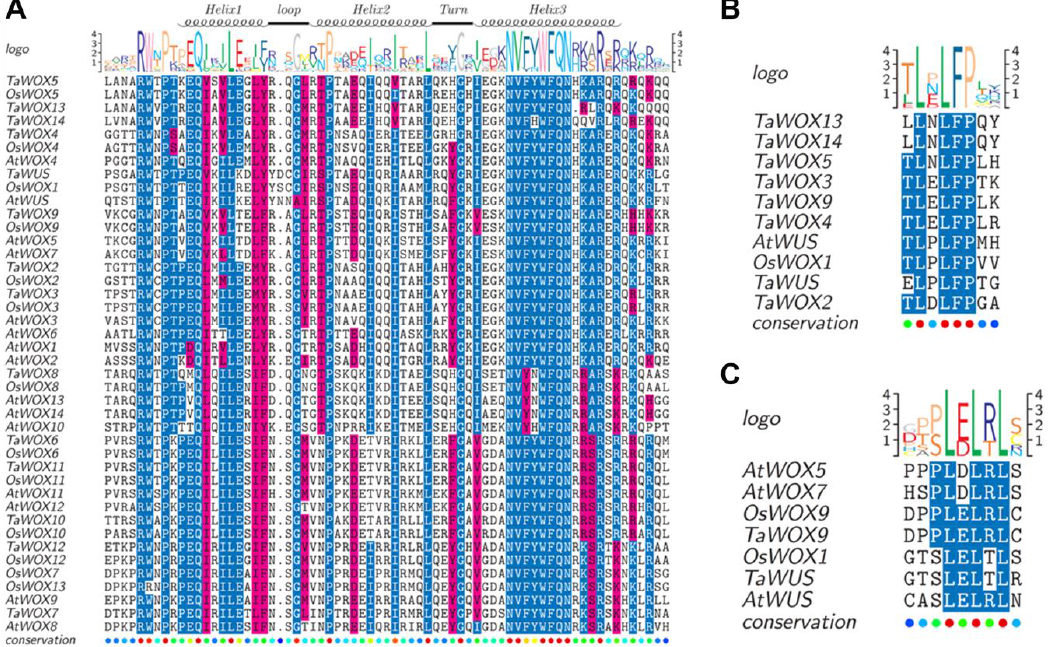
Figure 2. Functional domain analysis of WOX transcription factors in wheat. ( A ) Multiple sequence alignment among the homeodomain (HDs) of all WOX proteins from wheat, rice and Arabidopsis that carry this motif. ( B ) Multiple sequence alignment among the WUSCHEL (WUS)-box motifs of all WOX proteins from wheat, rice and Arabidopsis that carry this motif. ( C ) Multiple sequence alignment among the ERF-associated amphiphilic repression (EAR)-like motifs of all WOX proteins from wheat, rice and Arabidopsis that carry this motif. The basic sequence of the EAR-like motif was LXLXLX. Due to the high similarity of protein sequences, only the homoeologs on the A genome were selected for sequence analysis. Sequence logos represent the information content of the aligned sequences at a position in bit (max. 4.322 bit for proteins, i.e., log220) and the relative frequency of an amino acid at this position. Red font represents “similar”, blue font represents “ ≥ 50% conserved” and black front represents “non-conserved”. The color scales in the bottom consensus line represent the degree of sequence conservation (deep red represents the highest degree of conservation, and dark blue represents the lowest degree of conservation).